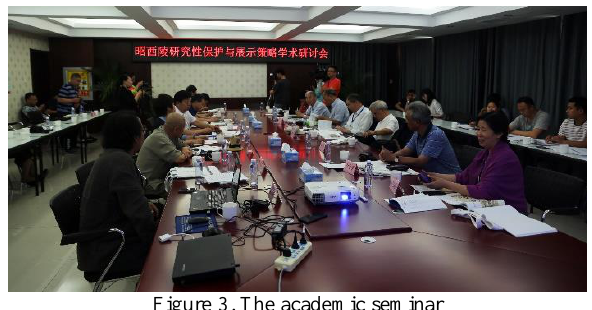
Figure 3. The academic seminar